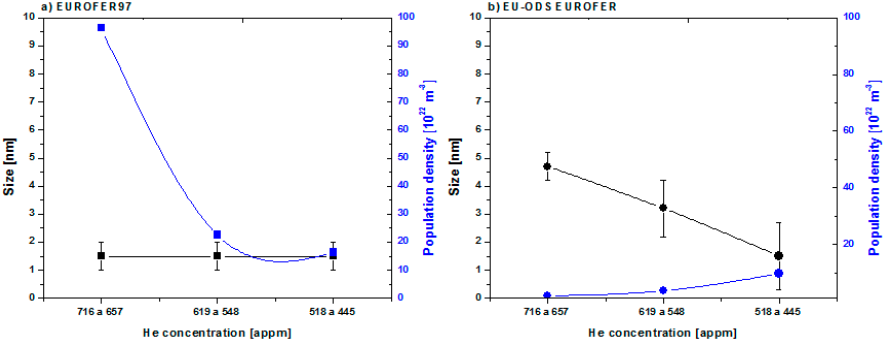
Figure 18. Cavity size and population density measured along the implantation depth profile for ( a ) EUROFER97 and ( b ) EU-ODS EUROFER.